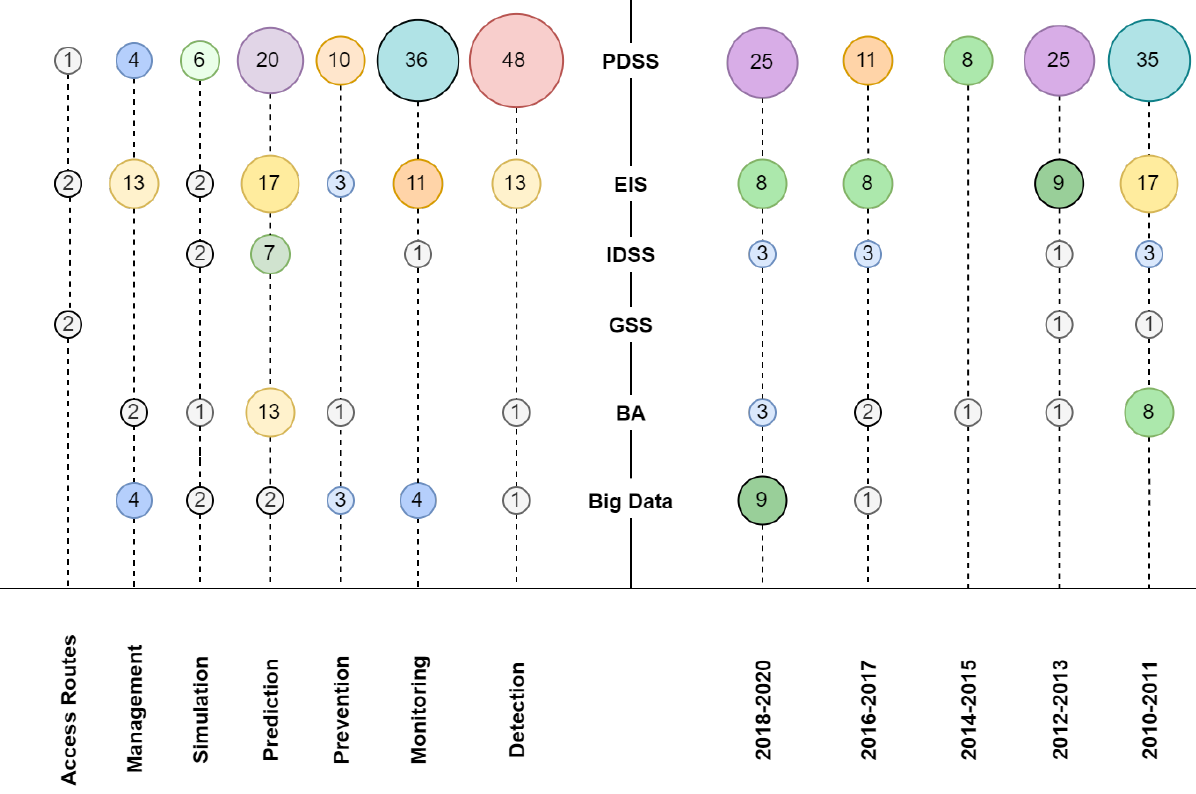
Figure 5. Systematic map.